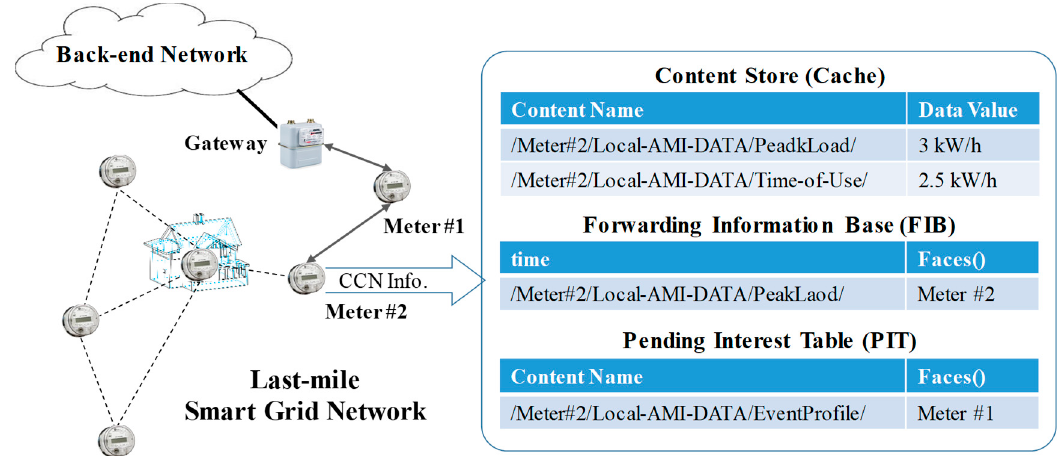
Figure 1. System model of Content Centric Networking (CCN)-based Last-mile Smart Grid Network for Advanced Metering Infrastructure.